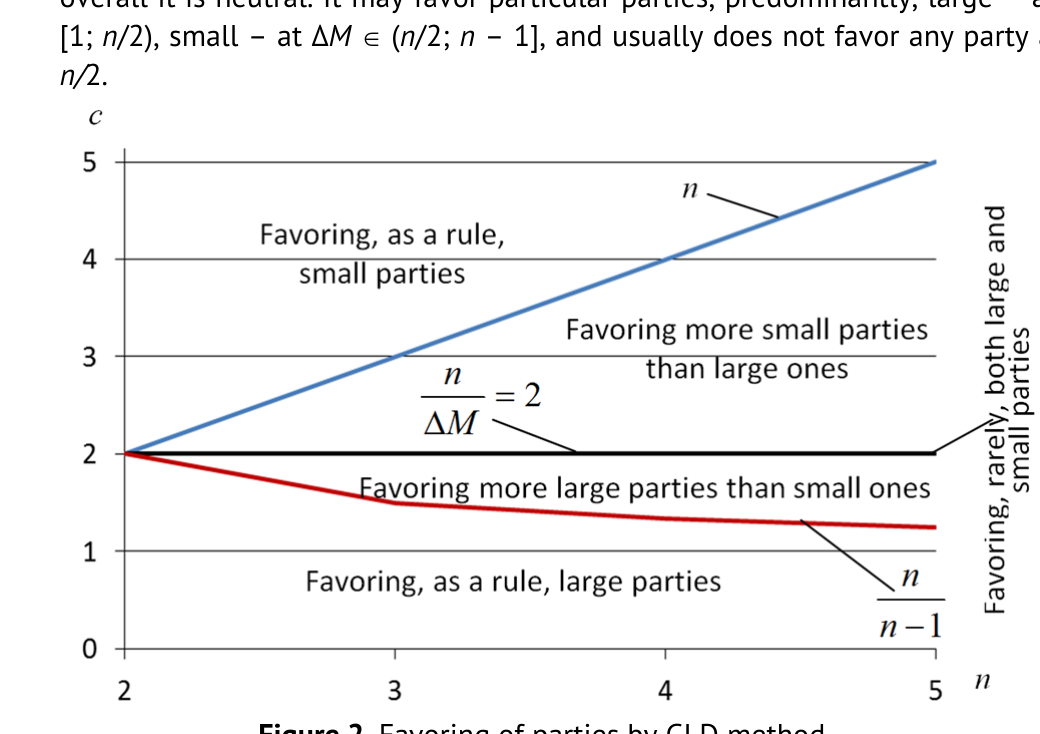
Figure 2 . Favoring of parties by GLD